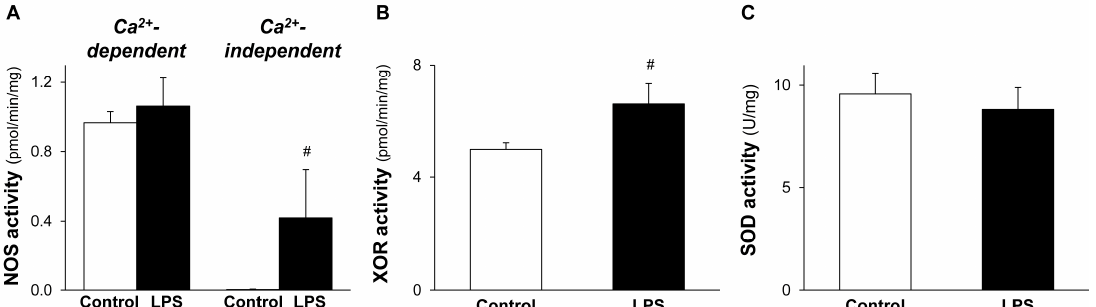
Figure 4. NOS and XOR enzymes contribute to elevated NO and O 2• − production induced by lipopolysaccharide (LPS). Figure shows cardiac NO synthases (NOS) ( A ), xanthine oxidoreductase (XOR) ( B ), and superoxide dismutase (SOD) ( C ) activities 24 h after in vivo 0.5 mg/kg LPS treatment. Values are expressed as mean ± S.E.M. ( n = 7–12). # p < 0.05 vs. control, unpaired t -test.